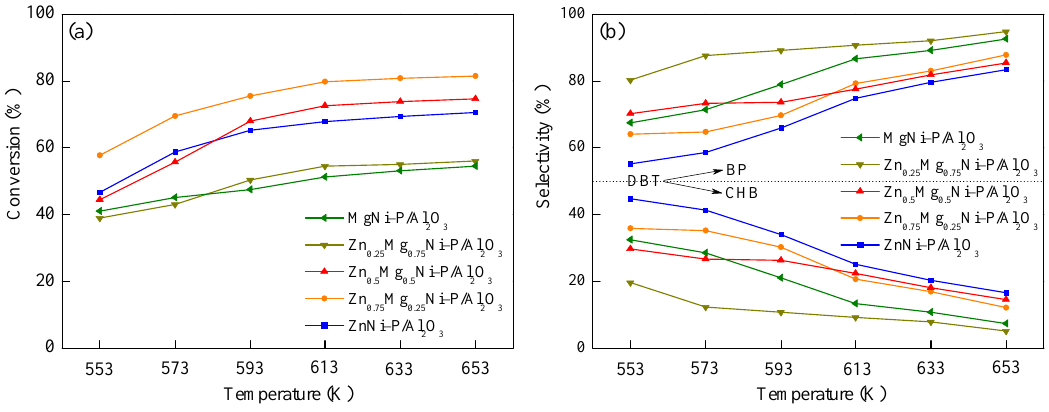
Figure 6. Evolution of conversion ( a ) and selectivity ( b ) of dibenzothiophene (DBT) hydrodesulfurization (HDS) over Zn x Mg 1 − x Ni–P/Al 2 O 3 catalysts, P = 3 MPa, weight hourly space velocities (WHSV) = 2.0 h − 1